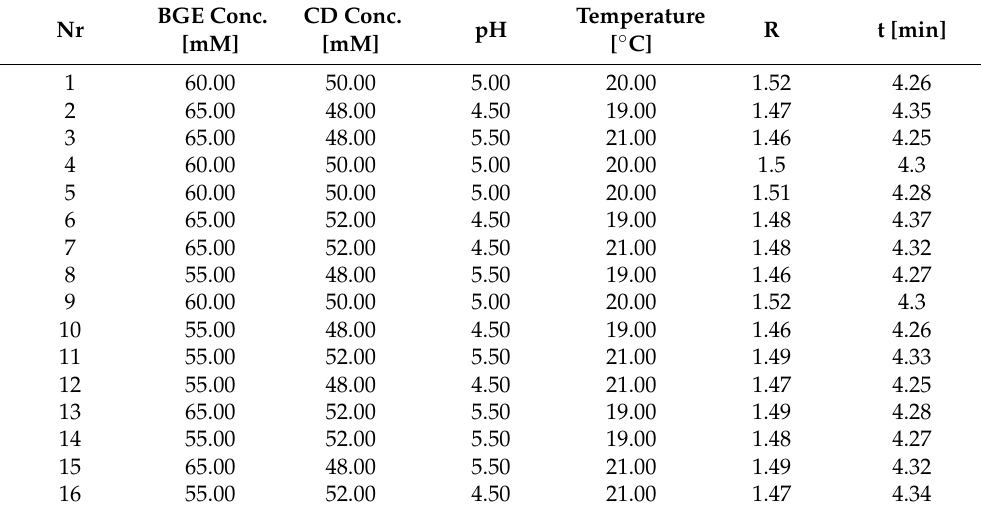
Table 5. Plackett–Burman design for robustness